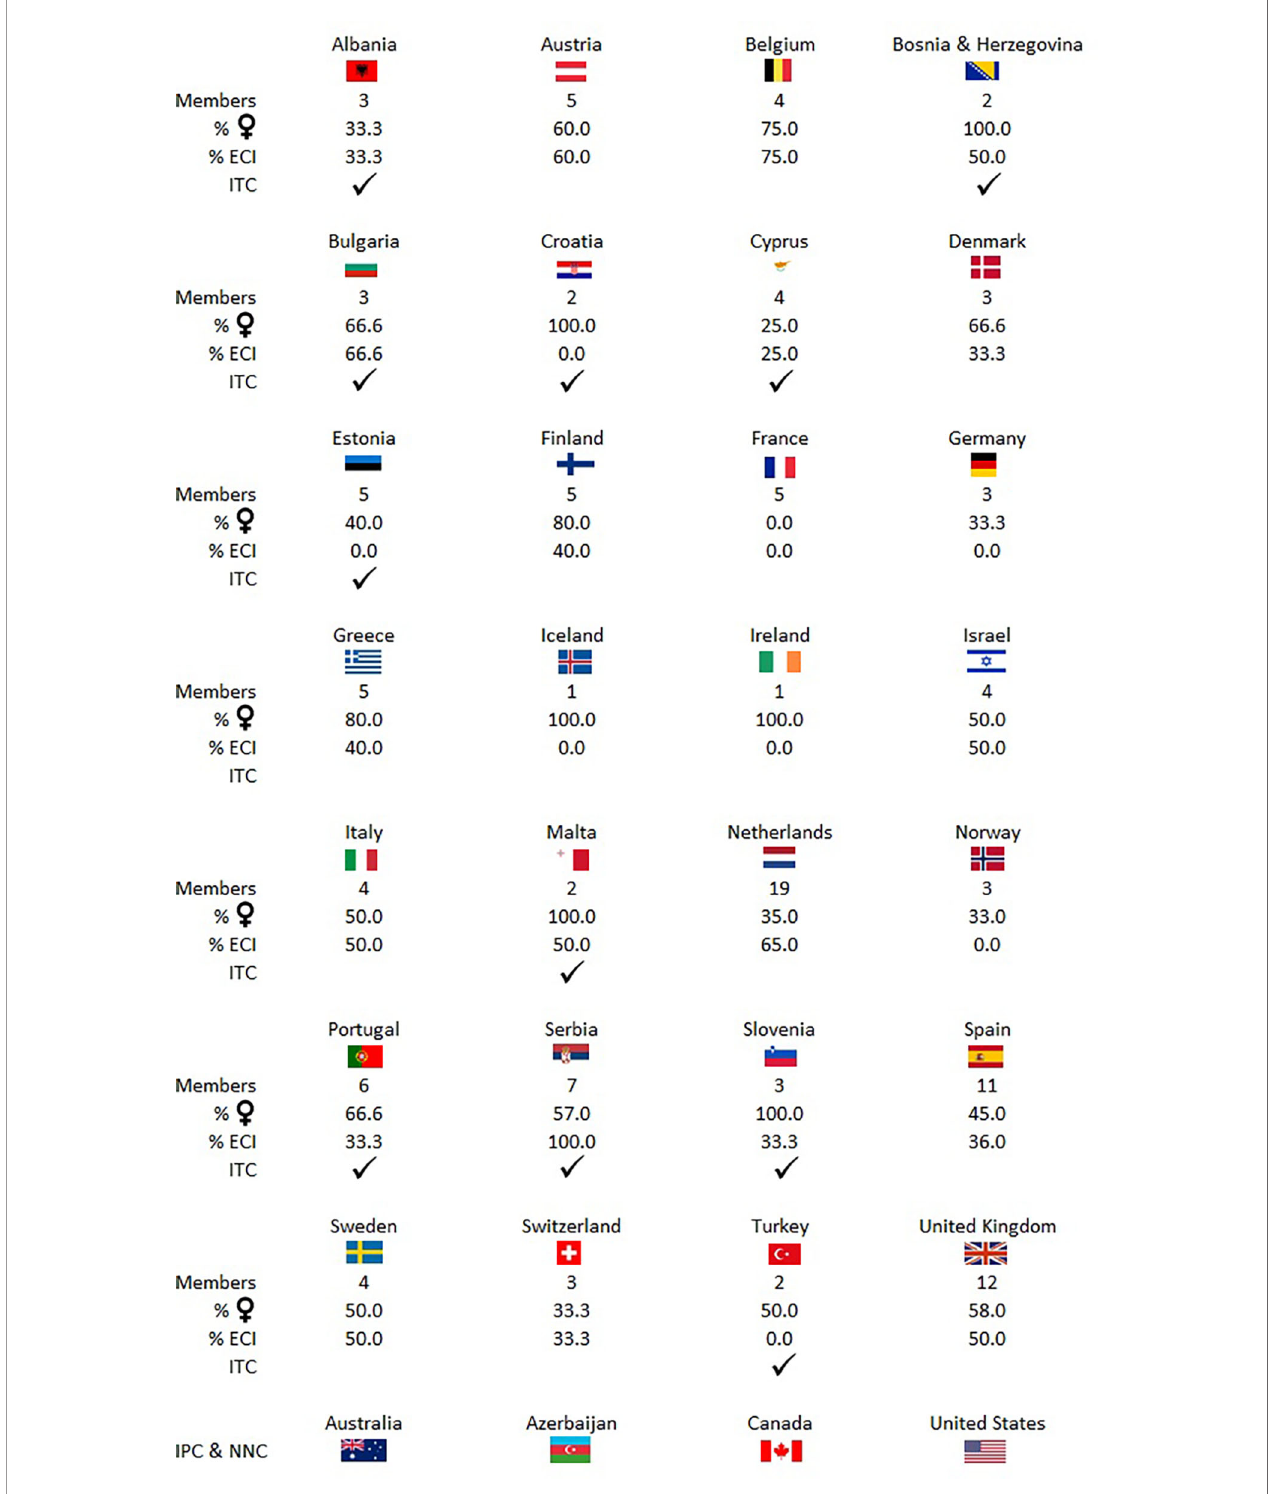
FIGURE 4 | There are currently 140 researchers in the network coming from at least 32 countries inside and outside Europe. This fi gure shows the number of members, percentage of women, percentage of early career investigators (ECI) per country, and info on whether the given country is and inclusiveness target country (ITC). NNC, near neighbouring country; IPC, international partner